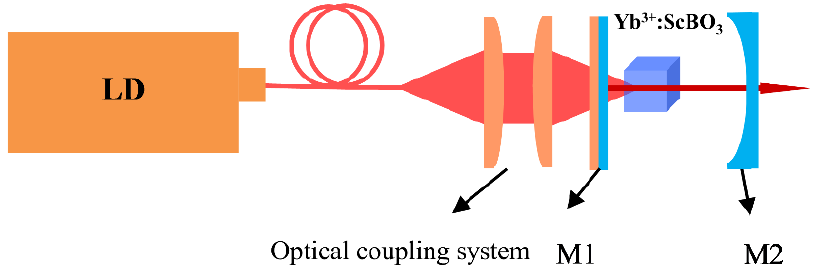
Figure 7. The experimental setup of continuous laser. (Source: [34], © 2015 Optica Publishing Group, Washington, DC, USA).